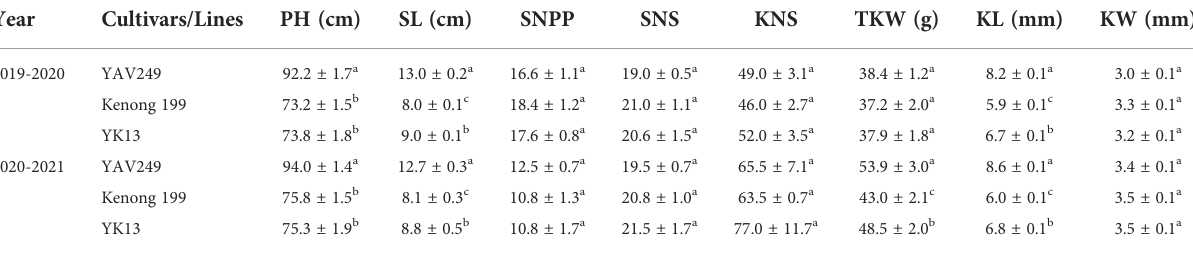
TABLE 2 The agronomic trait evaluation of the advanced breeding line YK13 with its donor parent YAV249 and recurrent parent Kenong 199. Year